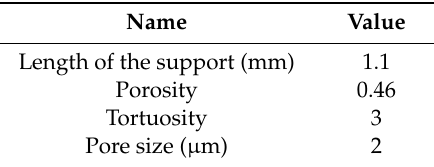
Table 1. Parameters of porous